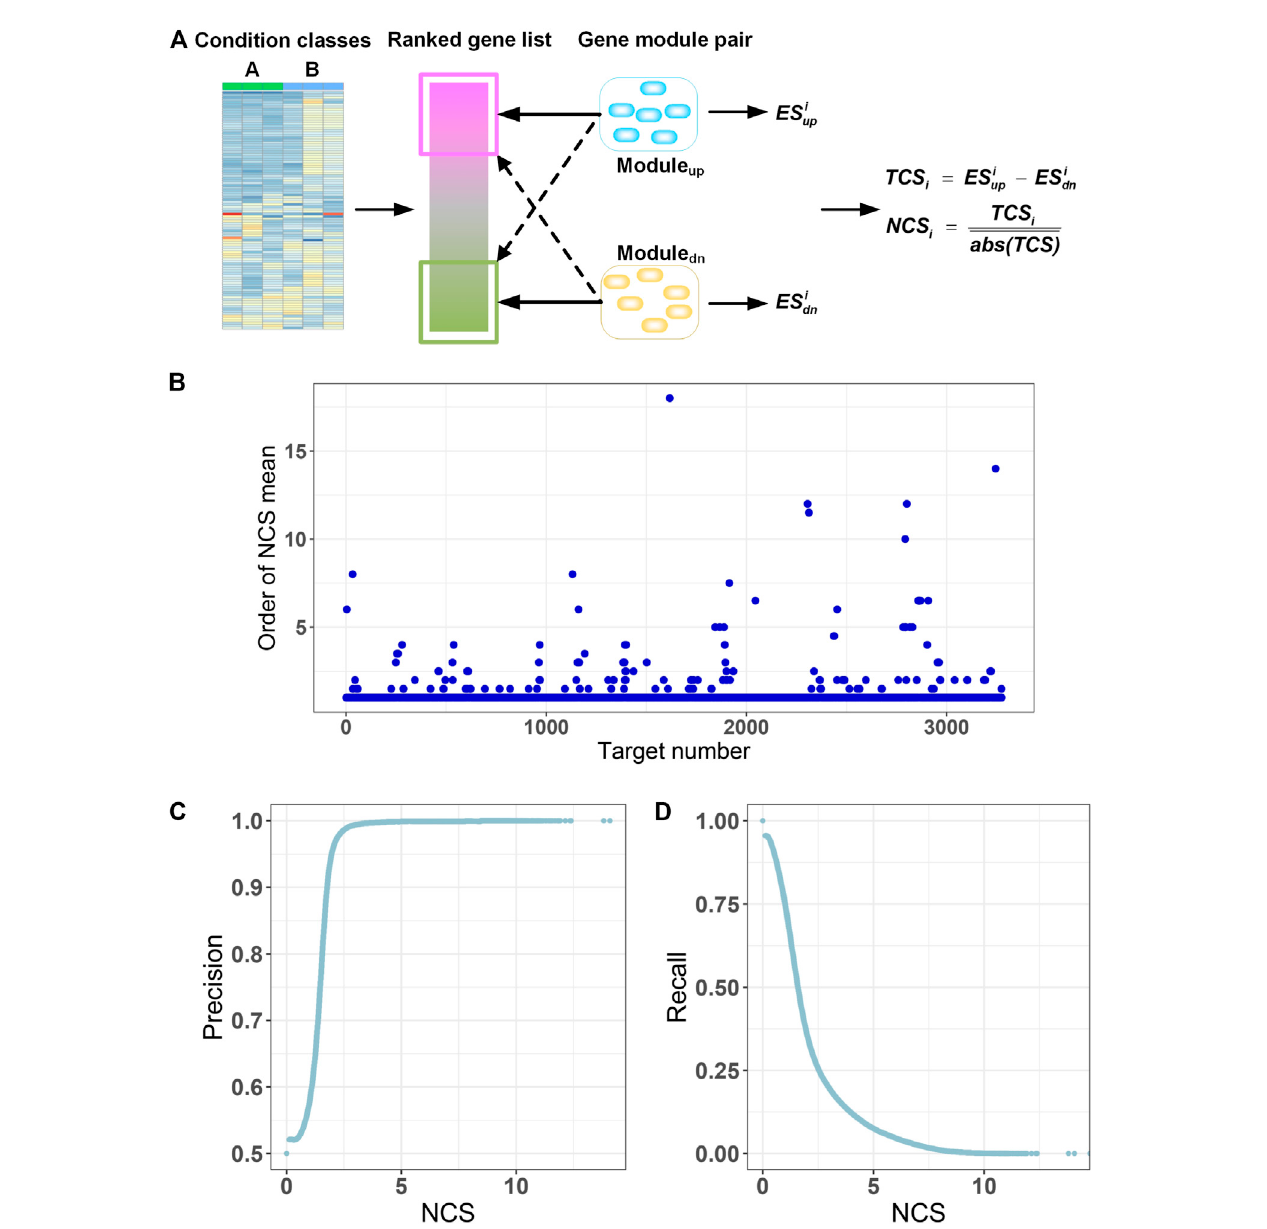
FIGURE 3 Gene module pair-based target identi fi cation . (A) A ranked gene list between two classes is compared with GMPs of all targets. A total correlation score ( TCS i ) is used to quantify the correlation between the gene list and each GMP by an adjusted gene set enrichment approach. Then, the TCS is divided by absolute means of the TCS scores for all GMPs to get a normalized correlation score ( NCS i ) with respect to the query. (B) Mean of NCS for all transcriptional signatures of each target is calculated for all GMPs and ranked. Because there may be multiple transcriptional signatures for a target in the L1000database,wecalculatedthemeanofmultipleNCSvalues foreachtargetrelativetoallGMPs.Then, foreachtarget,NCSmeanvaluesforallGMPswere ranked in descending order by the absolute values, and the order of the GMP the target itself is extracted and displayed. The horizontal axis displays the 3,275targets.TheverticalaxisistheorderoftheNCSmeanvalueforatargetandtheGMPofthetargetitself. (C) PrecisionatdifferentNCScutoffs. (D) Recallat different NCS